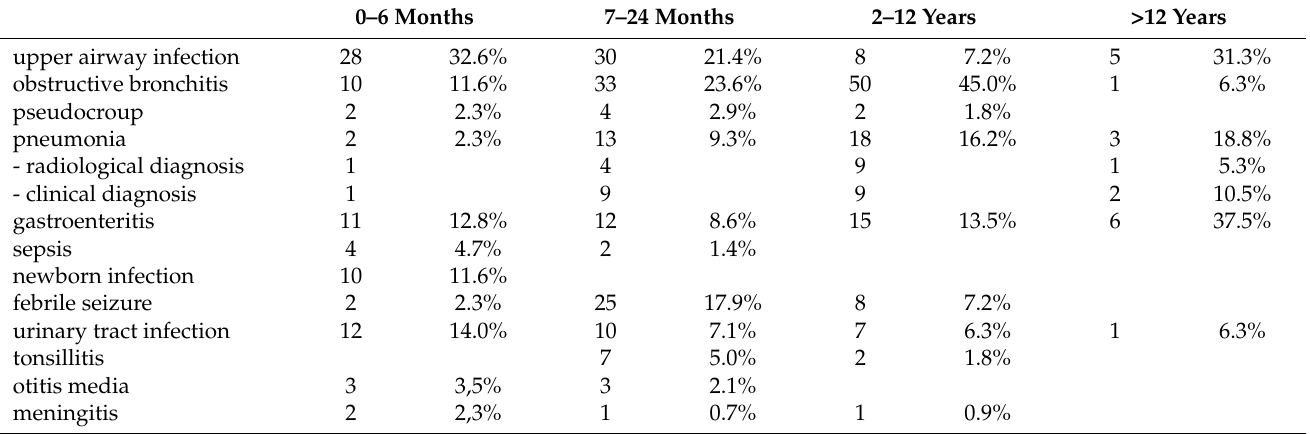
Table 4. Final diagnosis of patients admitted to the pediatric department with clinical suspicion for SARS-CoV-2 infection but negative SARS-CoV-2 PCR from oropharyngeal swab. The percentage refers to total number of children with the respective diagnosis in all age groups. Some patients carried more than one infectious diagnosis while some other patients were categorized to non-infectious diagnoses only. Age is represented in months (mo) or years